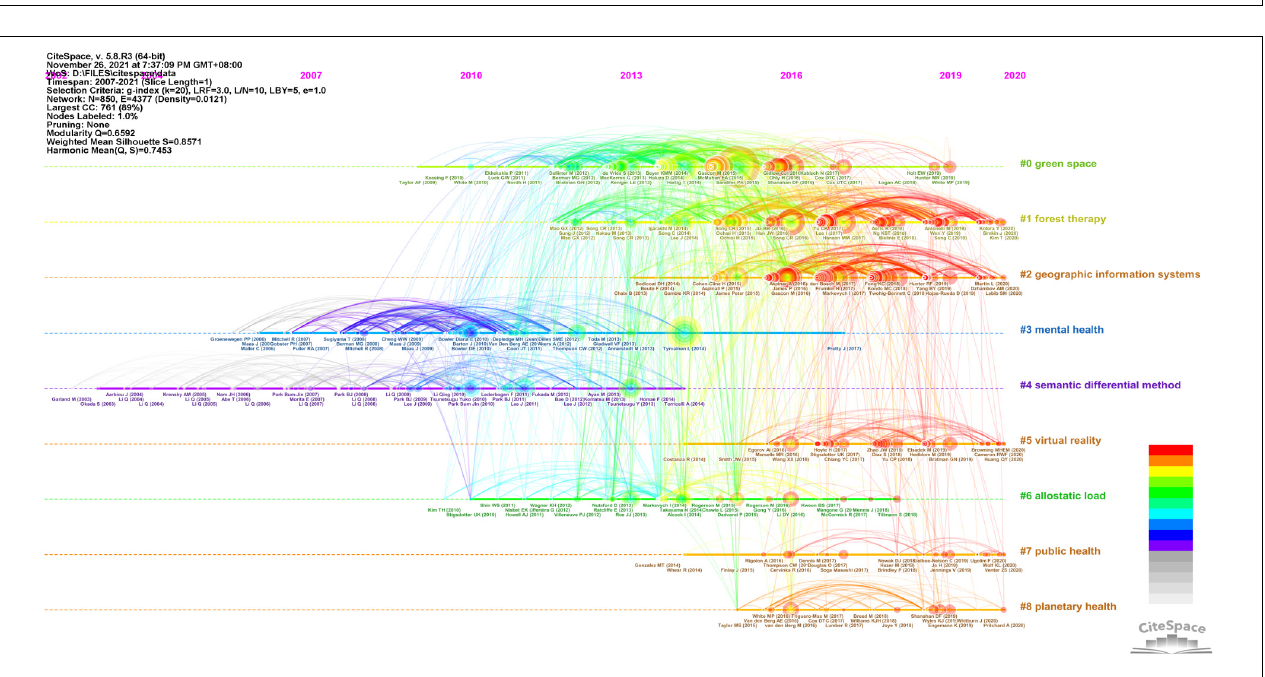
State-Trait Anxiety Inventory (STAI) (Song et al., 2013; Lee et al., 2014) were also frequently